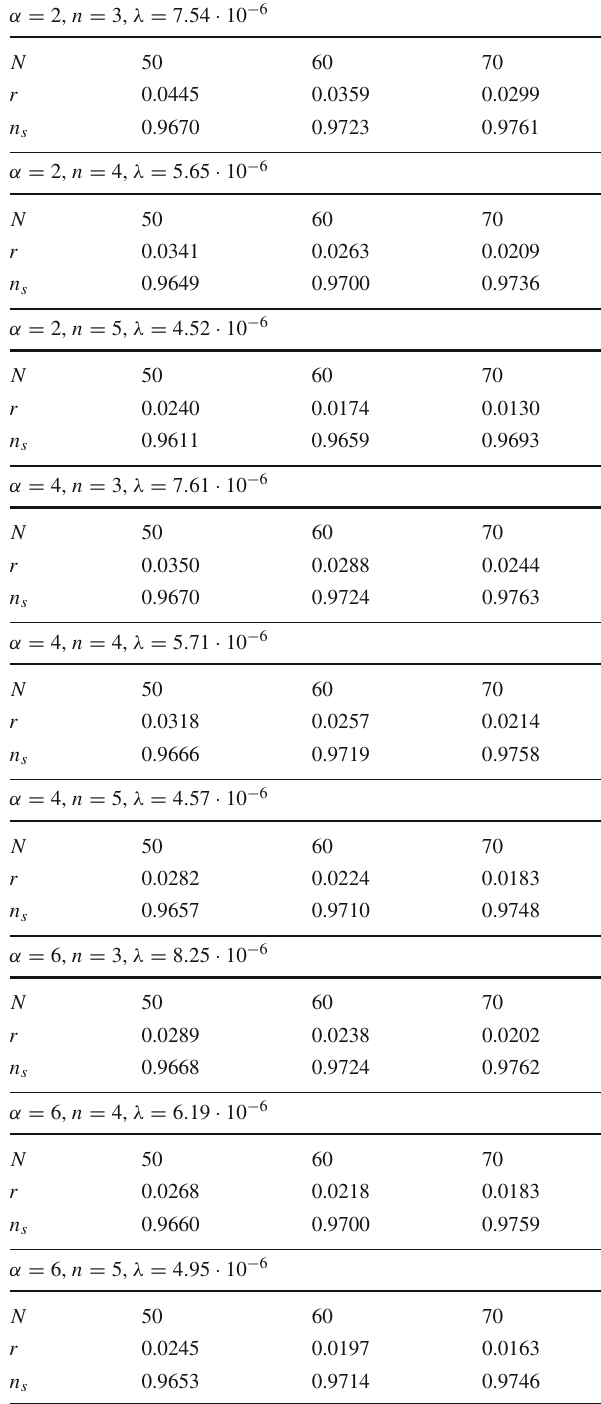
Table 1 Predictions for the scalar spectral index n s and the tensor-to- scalar ratio r for the scenario of non-canonical inflation with deformed- steepness potential, for various combinations of α and n , adjusting the values of λ in order to satisfy the observational constraint (2.22), and for e-folding number N equal to 50, 60 and 70. For this Table we fix M = 10 − 6 M pl and V 0 = 10 − 16 M 4 , with M pl = 10 18 GeV , while pl the value of λ is determined through the observational constraint